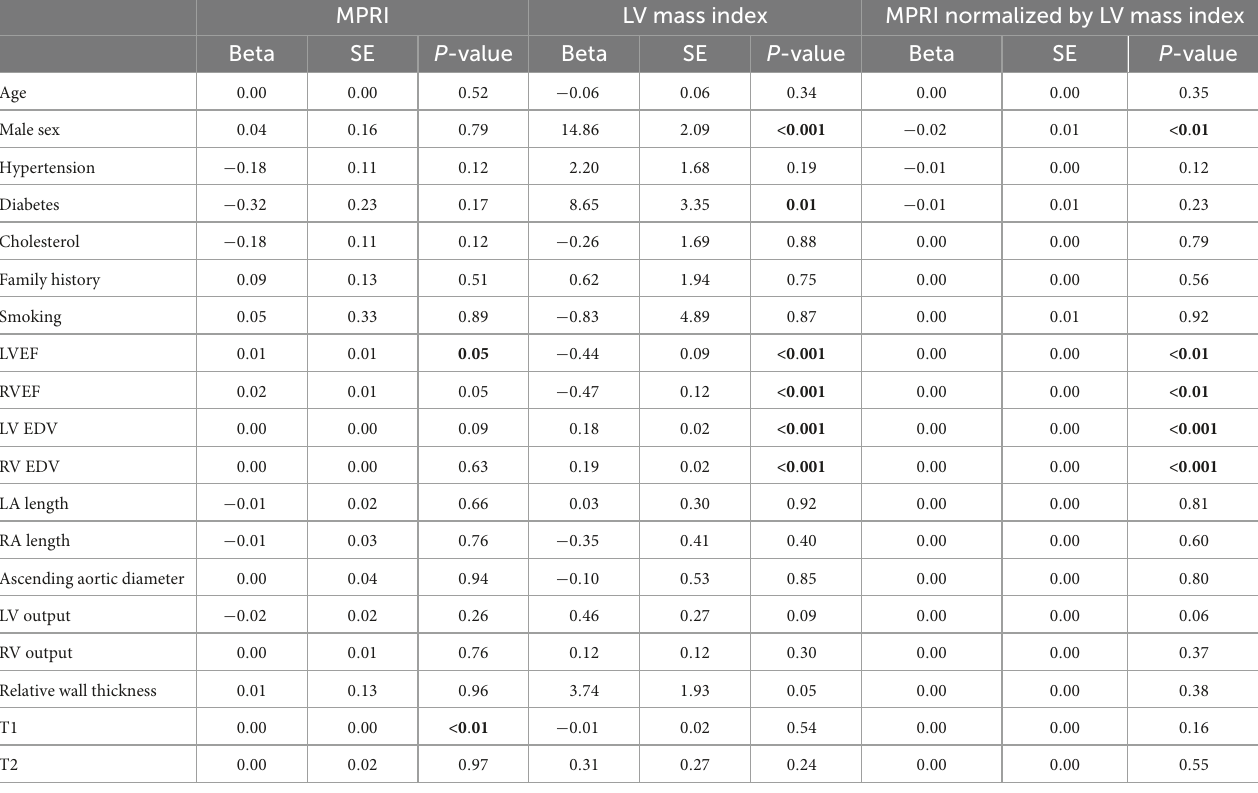
TABLE 4 Univariable associations of traditional risk factors and measures of cardiac structure and function with myocardial perfusion reserve index (MPRI), left ventricular mass index, and myocardial perfusion reserve index normalized by left ventricular mass index. MPRI LV mass index MPRI normalized by LV mass